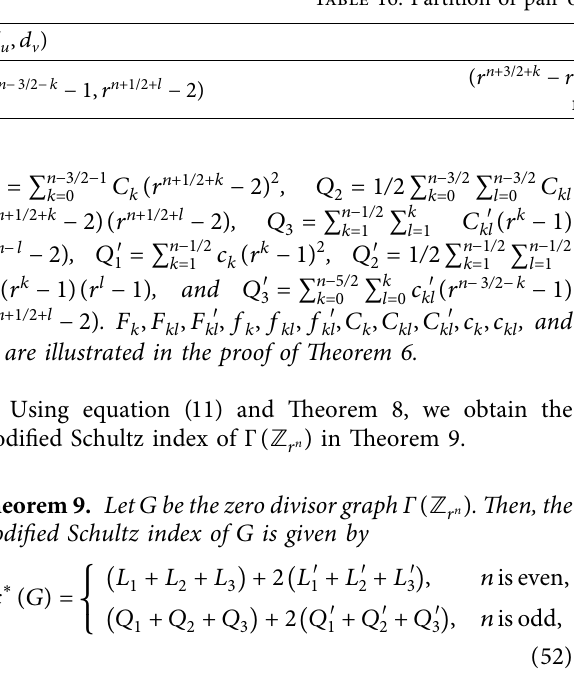
Figure 1: Te zero divisor graph Γ ( Z